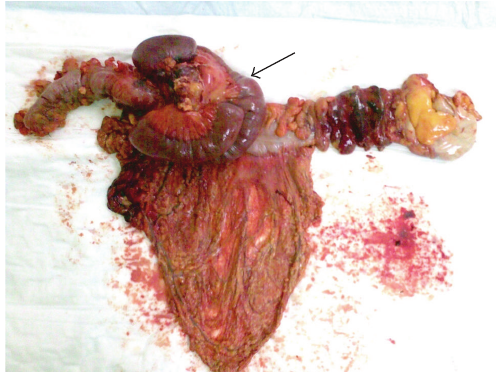
Figure 2: Resected colon with adherent small bowel loop (black arrow).